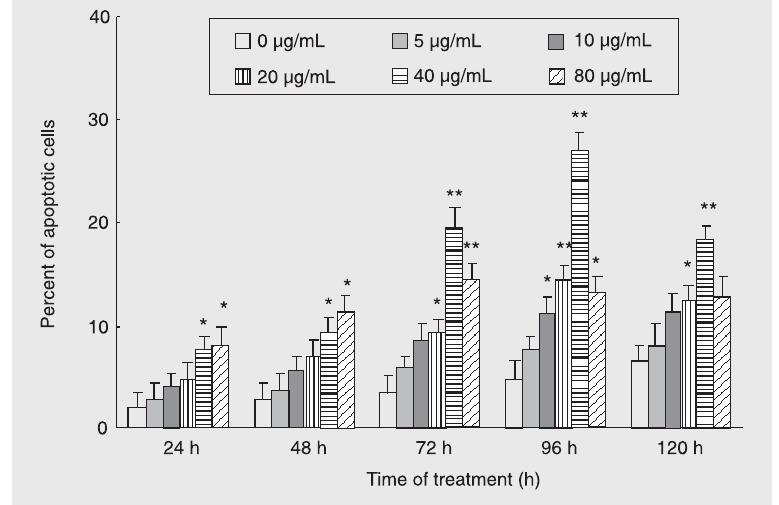
Figure 3. Effect of fraction FA-2- b-ß on the apoptosis of HL-60 cells showing the DNA ladder on agarose gel. HL-60 cells (1 x 10 5 cells/mL) were exposed to frac- tion FA-2-b-ß at the indicated doses for 96 h. Lane 1 , Control cells; lanes 2-6 , cells treated with 5, 10, 20, 40, and 80 µg/mL fraction FA-2-b-ß for 96 h, re- spectively. M = molecular size markers (100